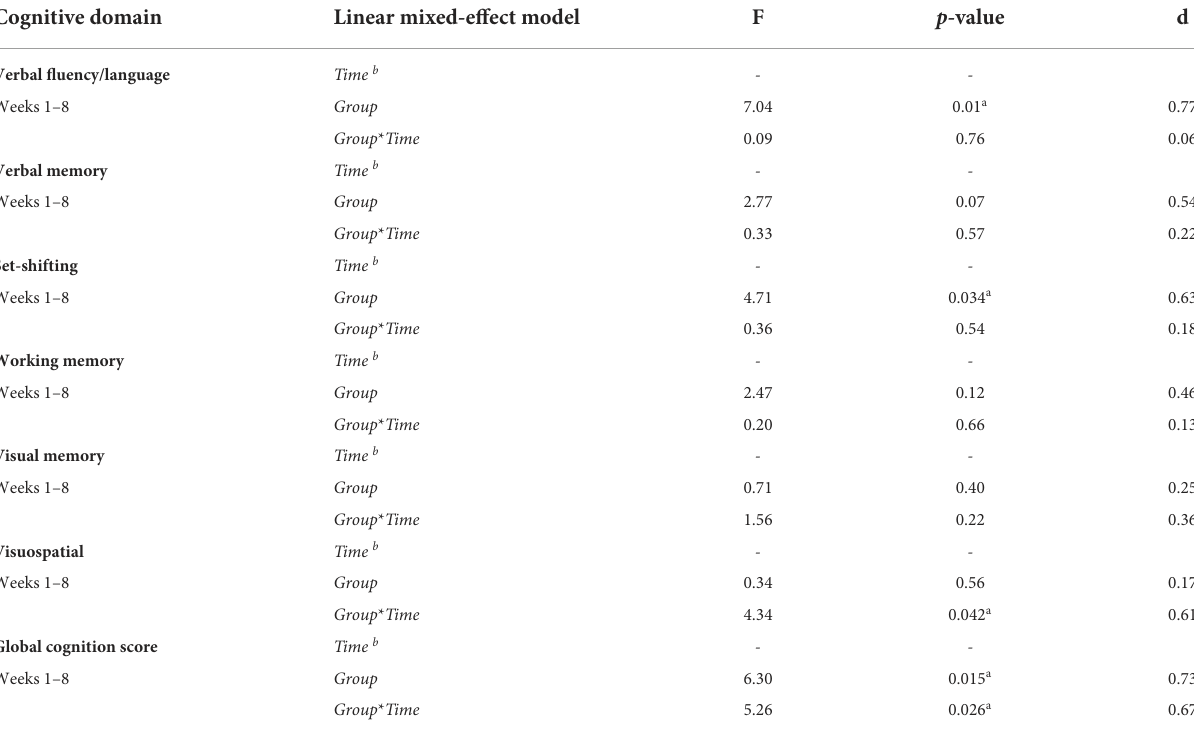
TABLE 5 Exercise engagement effect on